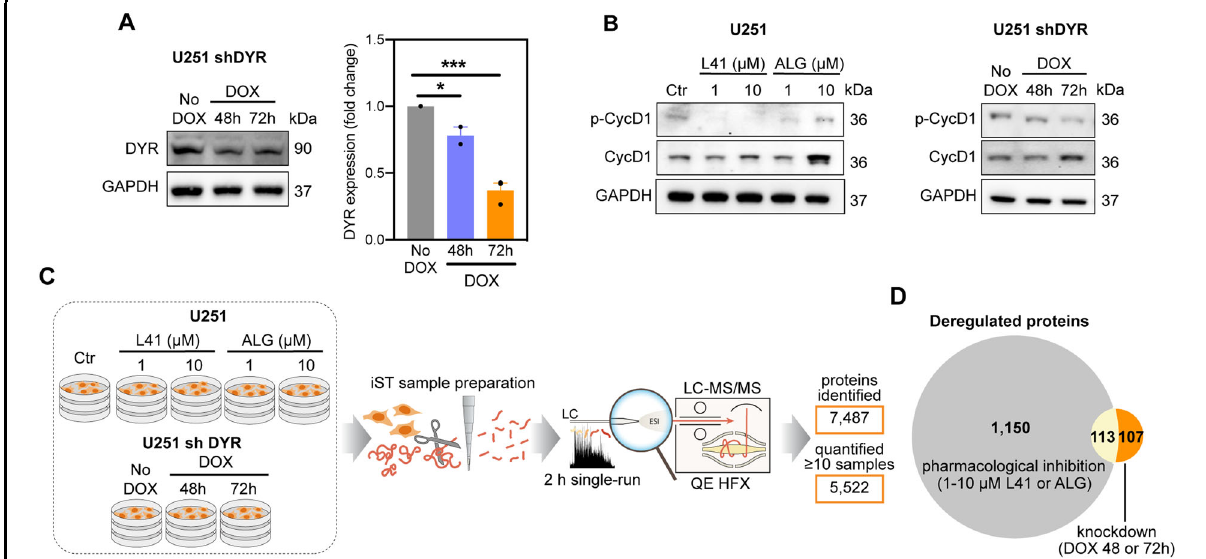
Fig. 1 Proteomic characterization of DYRK1A inhibition in U251 glioblastoma cells. A DYRK1A (DYR) expression in U251 cells transfected with doxycycline (DOX)-inducible shRNA targeting DYRK1A (U251 shDYR). Representative images and densitometric quanti fi cation of three independent experiments are shown (mean ± SEM, unpaired t -test, * P < 0.05; *** P < 0.001). B Expression of phosphorylated (p-CycD1) and total cyclin D1 (CycD1) in U251 cells treated ± DYRK1A inhibitors L41 and ALGERNON (ALG) for 72 h, and in U251 shDYR cells treated ± DOX. Representative images of two independent experiments are shown. C Design and summary of the proteomic analysis of U251 cells treated ± L41 and ALG for 72 h, and U251 shDYR cells treated ± DOX. D Venn diagram showing overlap among proteins deregulated after DYRK1A pharmacological inhibition (1263 proteins total) and genetic knockdown (220proteins